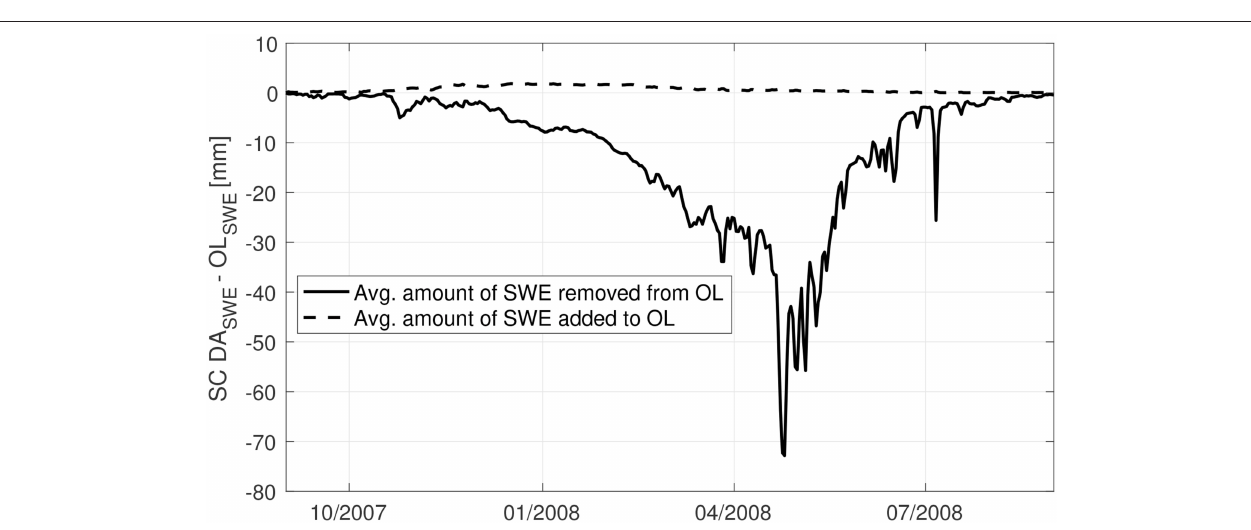
FIGURE 4 | The spatially averaged amount of SWE being removed or added from OL due to SC DA from 2007 to 2008. Grid cells that never go through any SC DA updates are removed from the calculation.